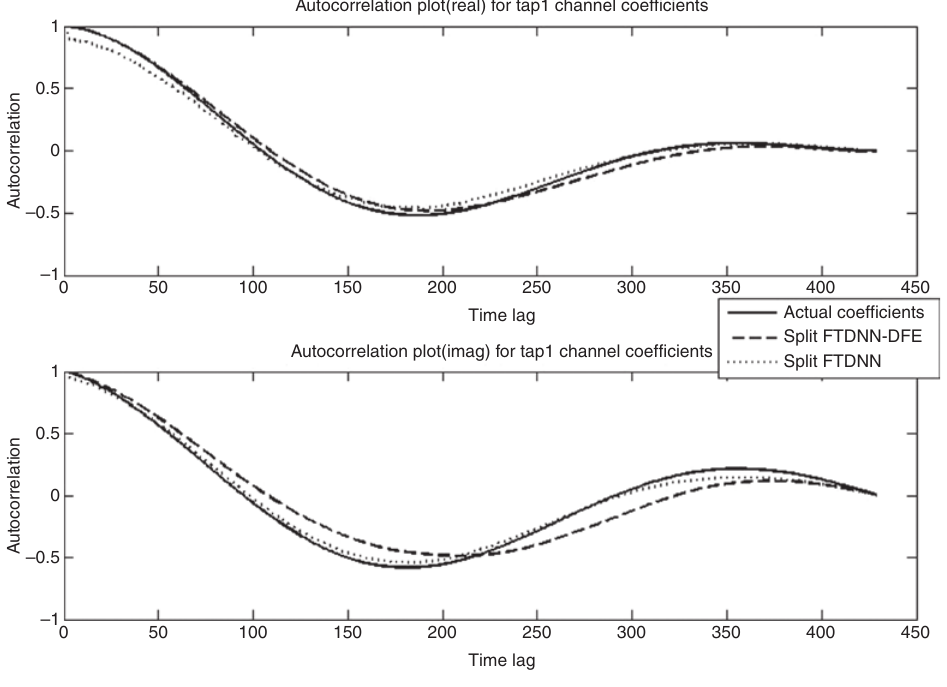
Figure 15: Autocorrelation Plot for Case 2. the learning based on FTDNN-DFE is much detailed and extensive compared to the rest. The 50 epochs are fixed for completing the learning for the fact that with larger number of training cycles, there are chances of overtraining and the channel estimation/equalization process becoming